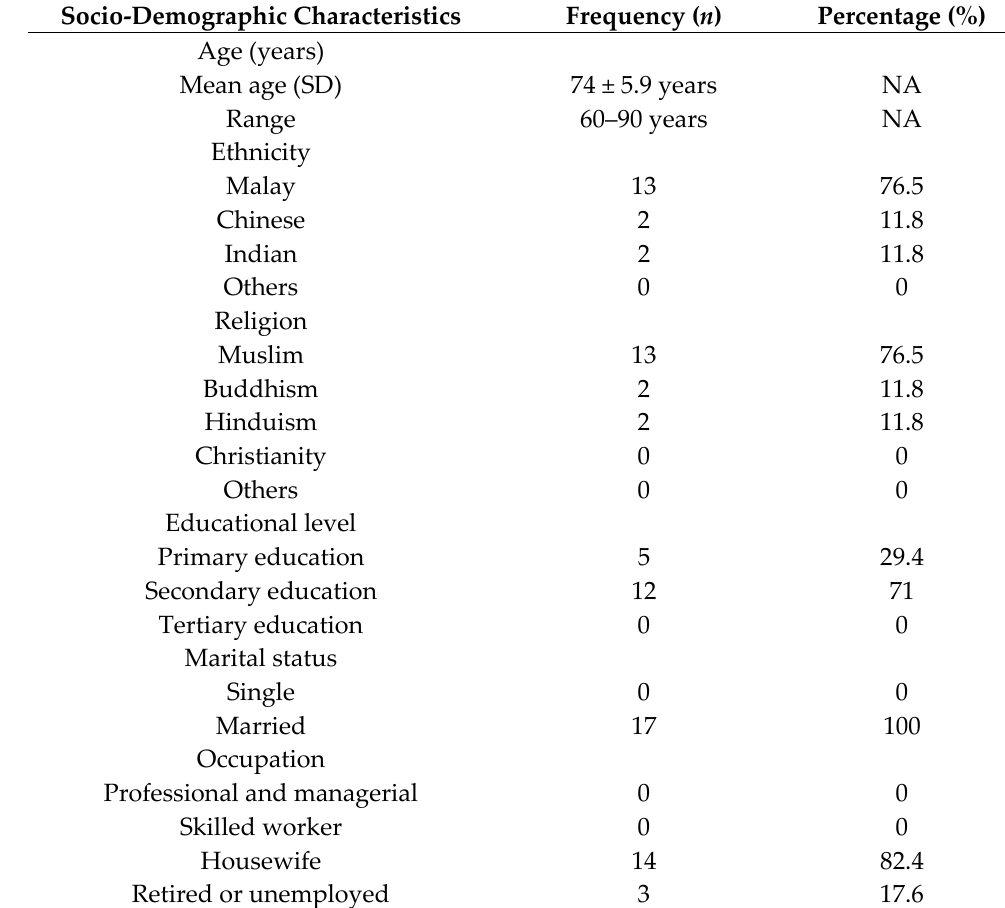
Table 2. Socio-demographic attributes of the